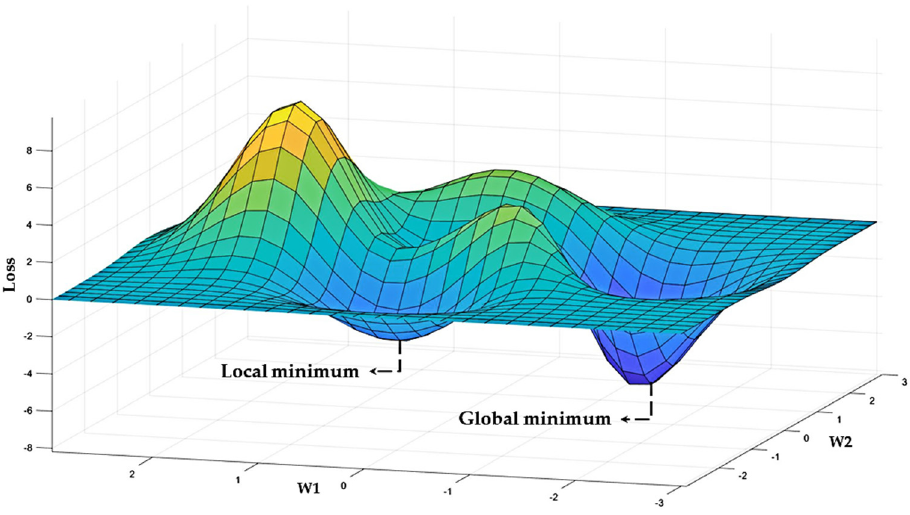
Figure 10. Res-Bp and BP loss and R 2 : ( a ) compensation loss of flight B data; ( b ) compensation loss of flight A data; ( c ) compensation R 2 of flight B data; ( d ) compensation R 2 of flight A data.